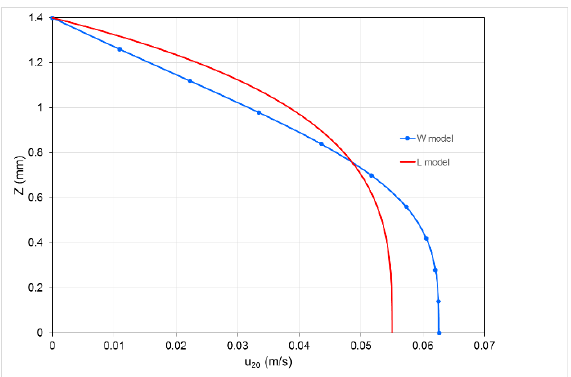
Figure 4. First-order velocity amplitude at the layer axis as a function of the frequency of disturbance for L and W models.